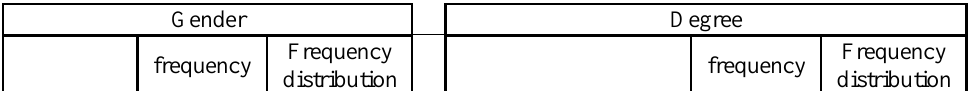
Table 2. Descriptive